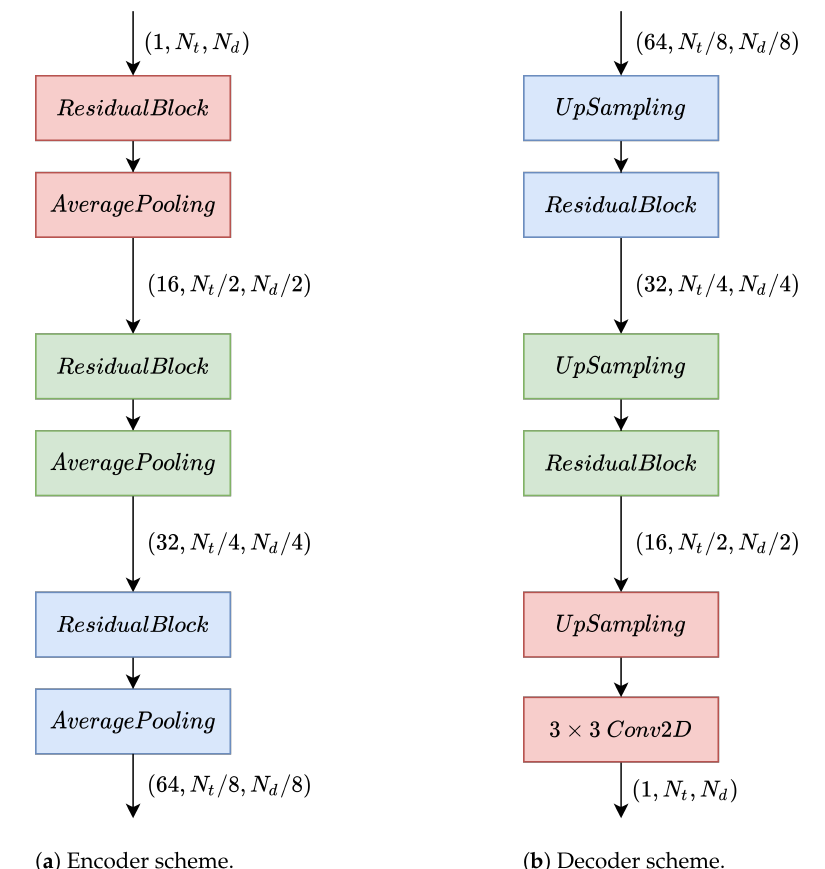
Figure 4. Autoencoder architecture used to obtain anomaly